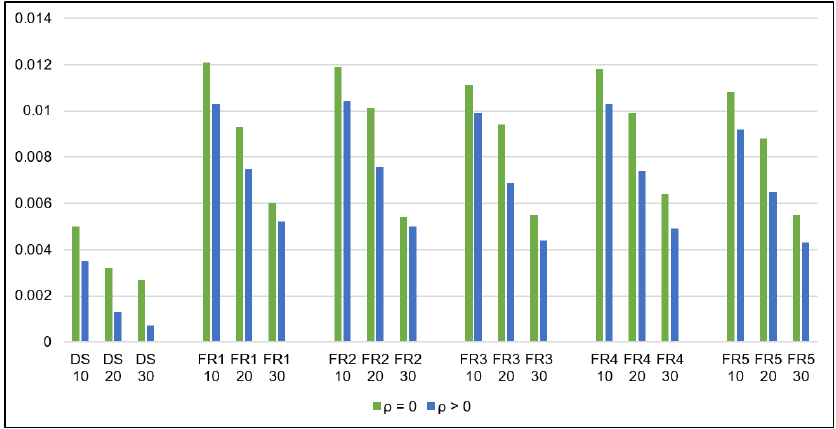
Figure 11. Effect of the LA regularizer represented by improvement in RMSE when ρ >